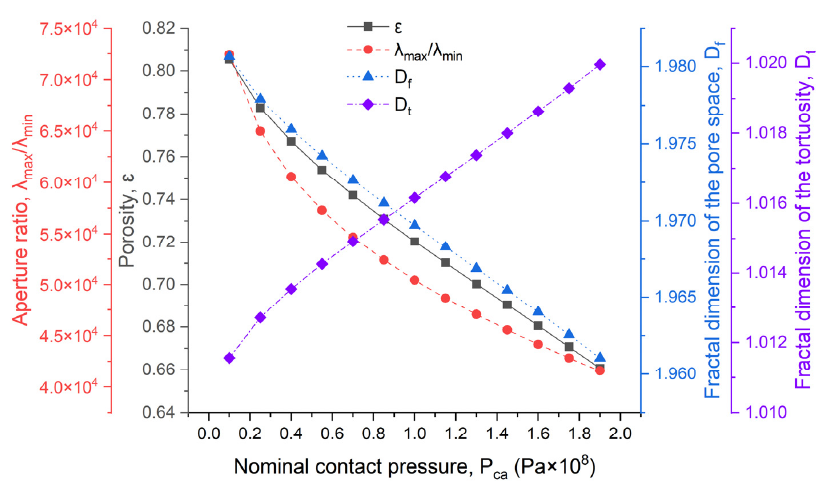
Figure 16. The influence of contact pressure on the intrinsic parameters of the porous medium.